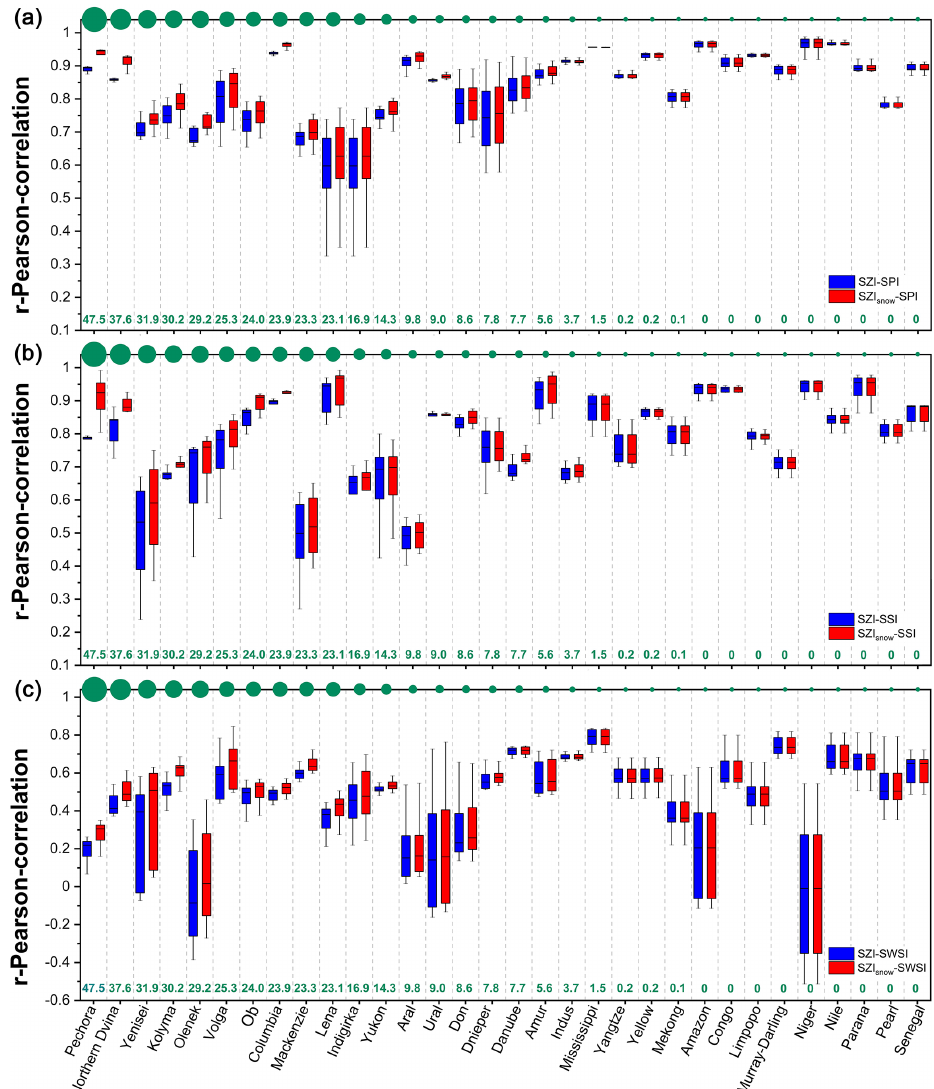
Figure 4. Comparisons between the SZI snow and SZI with regard to their performance in quantifying different types of drought. The SZI snow and SZI were correlated with observed drought indices across the 32 basins. The Pearson correlation coefficient ( r ) was applied to evaluate the correlation. (a) Performance of the SZI snow in quantifying meteorological drought. The blue boxes represent the statistical distribution of r between the SZI and SPI for timescales from 1 to 48 months in each basin, while the red boxes represent that between the SZI snow and SPI. (b) Performance of the SZI snow in quantifying hydrological drought (boxes represent same parameters as in (a) but correlations are with the SSI instead of the SPI). (c) Performance of the SZI snow in quantifying agricultural drought (boxes represent same parameters as in (a) but correlations are with the SWSI instead of the SPI). Basins were ranked in descending order based on their SWE. The green dots along the top of each x axis denote the SWE of each basin, and their sizes were scaled by the green SWE values given along the bottom of each x